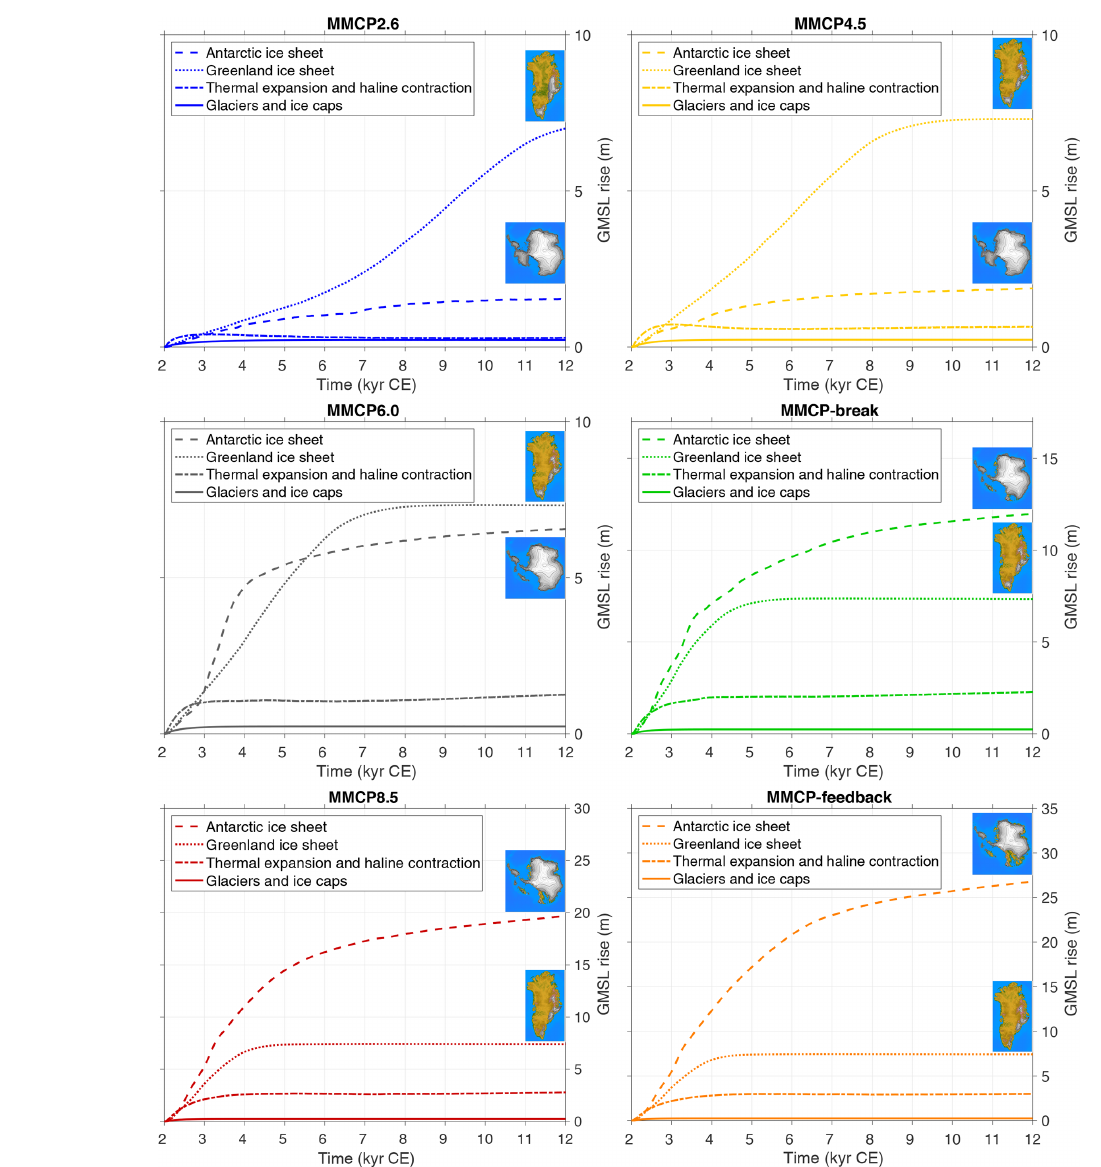
Figure 5. The contribution of the different components to GMSL rise during the next 10000 years for each of the forcing scenarios. The ice sheet geometry of Greenland and Antarctica is shown at the end of the